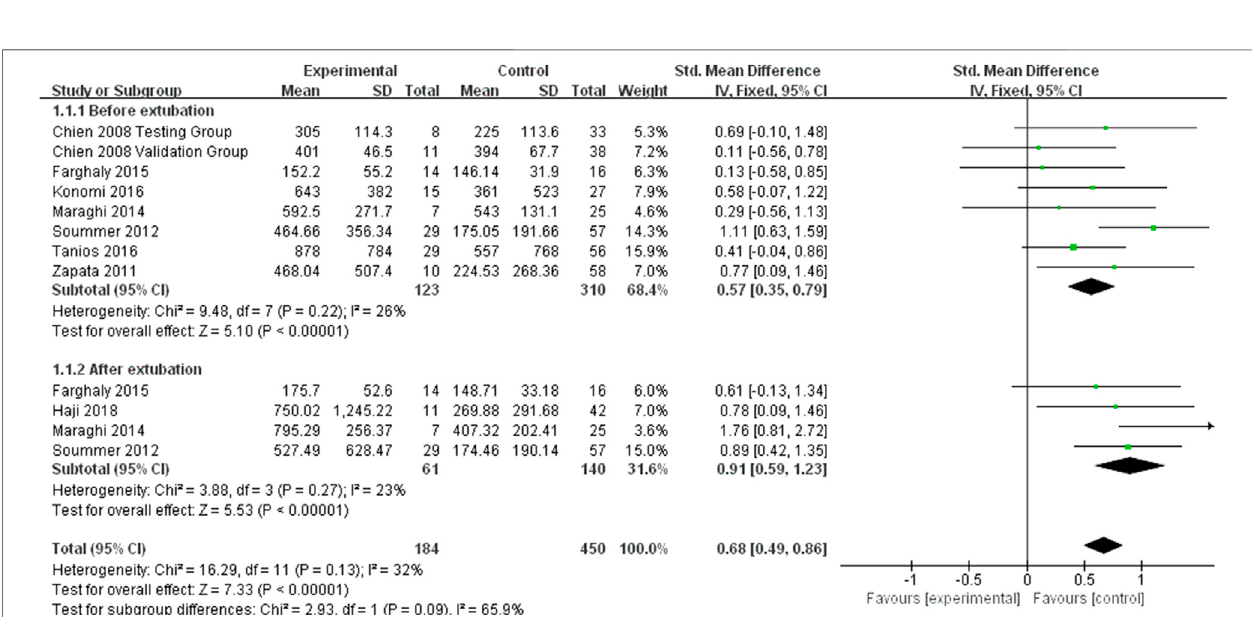
FIGURE 3 | The BNP levels standard mean difference between extubation failure and extubation success groups.